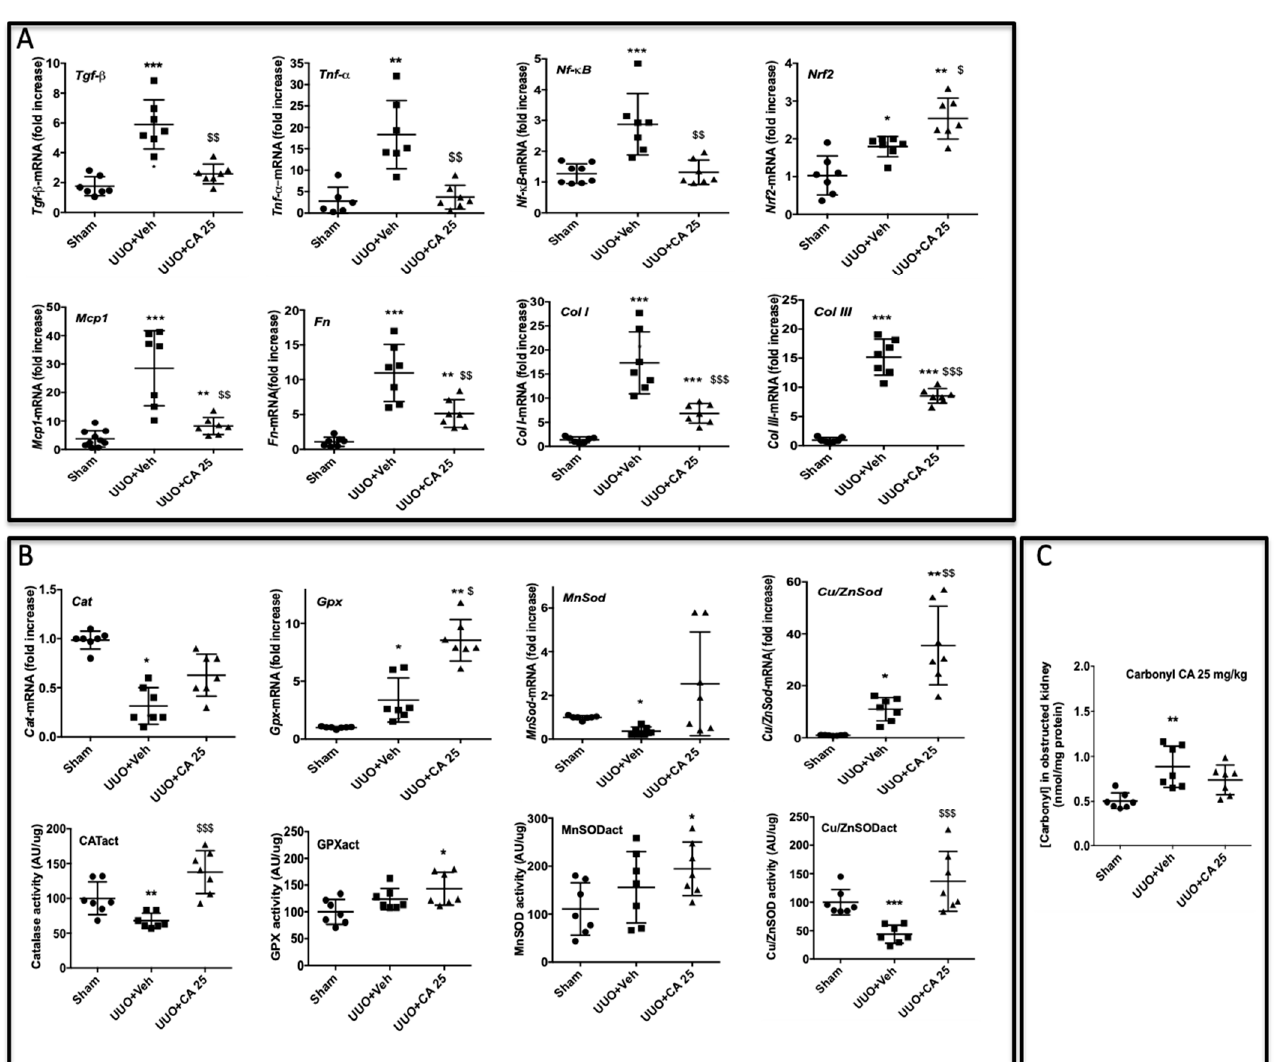
Figure 6. Caffeic acid (CA) 25 mg/kg restores normal inflammatory and oxidative stress parameters induced by UUO in mice. ( A ) Expression of genes involved in inflammatory and fibrotic responses in obstructed kidney, ( B ) antioxidant enzymes gene expression and activities and ( C ) the protein carbonyl concentration in obstructed kidney. n = 7 per group. * p < 0.05, ** p < 0.01, *** p < 0.001, compared to Sham; $ p < 0.05, $$ p < 0.01, $$$ p < 0.001, compared to UUO + Veh.